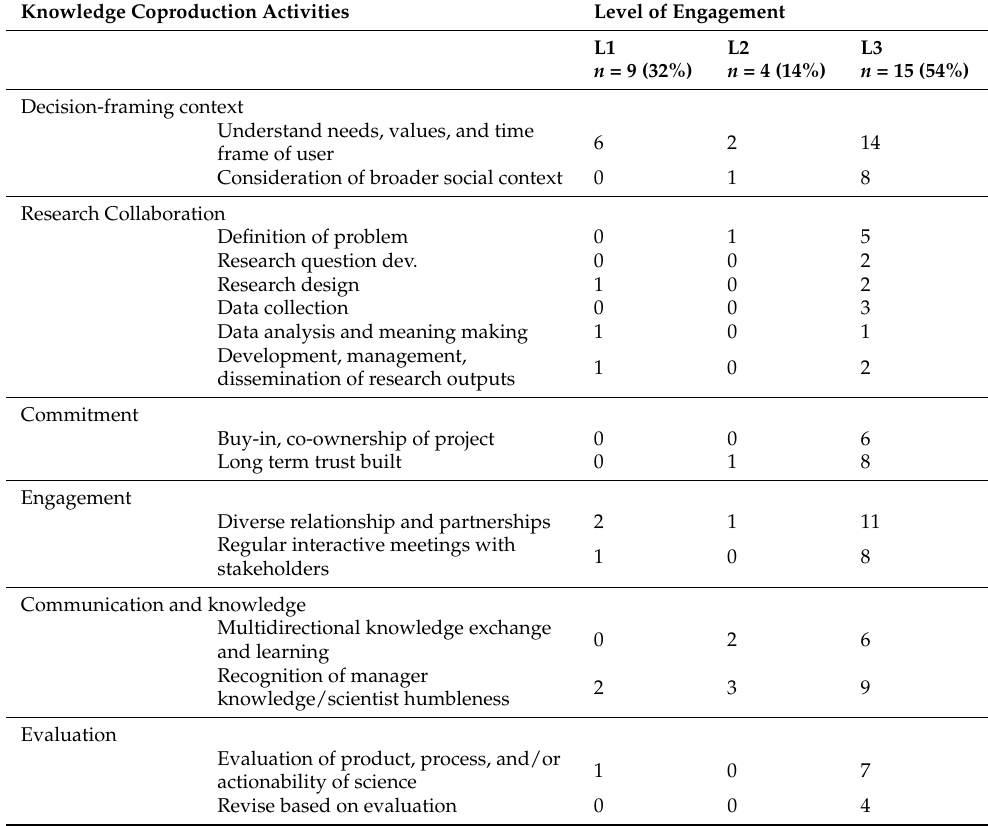
Table 2. Number of L1, L2, and L3 scientists involved in knowledge coproduction categories and